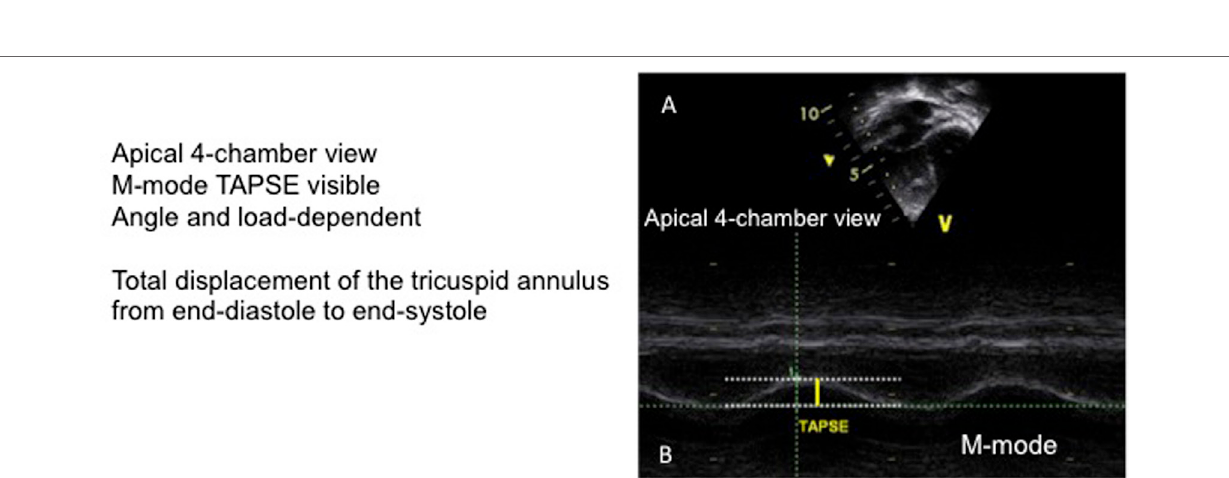
FigURe 7 | Tricuspid annular plane systolic excursion (TAPSE). (A) Four-chamber view of the right ventricle with ultrasound beam aligned on the tricuspid annulus. (b) Measurement of the TAPSE on the M mode